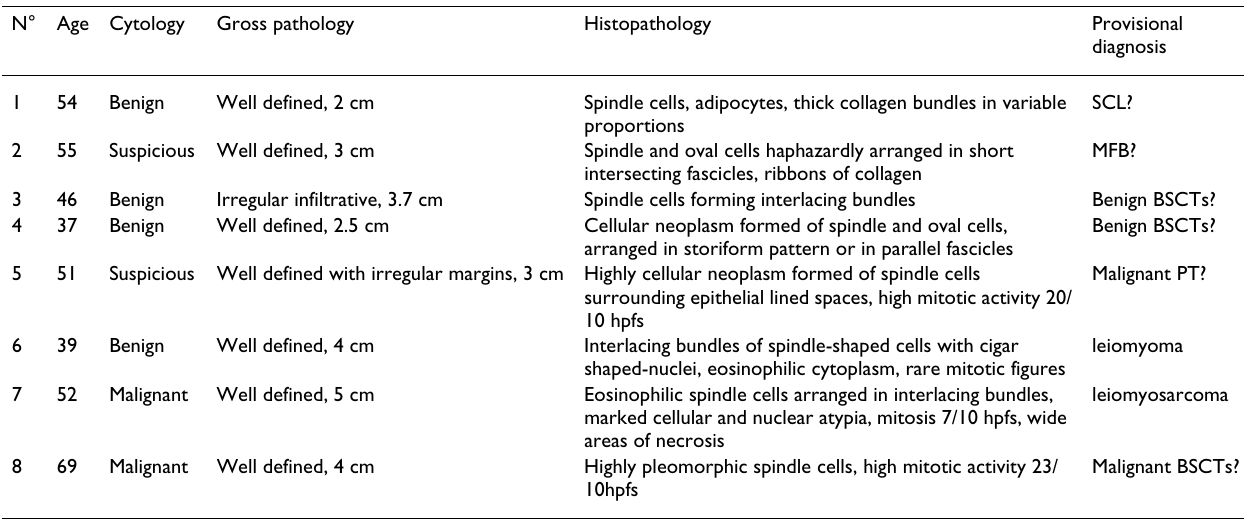
Table 2: Patients' pathological summaries N° Age